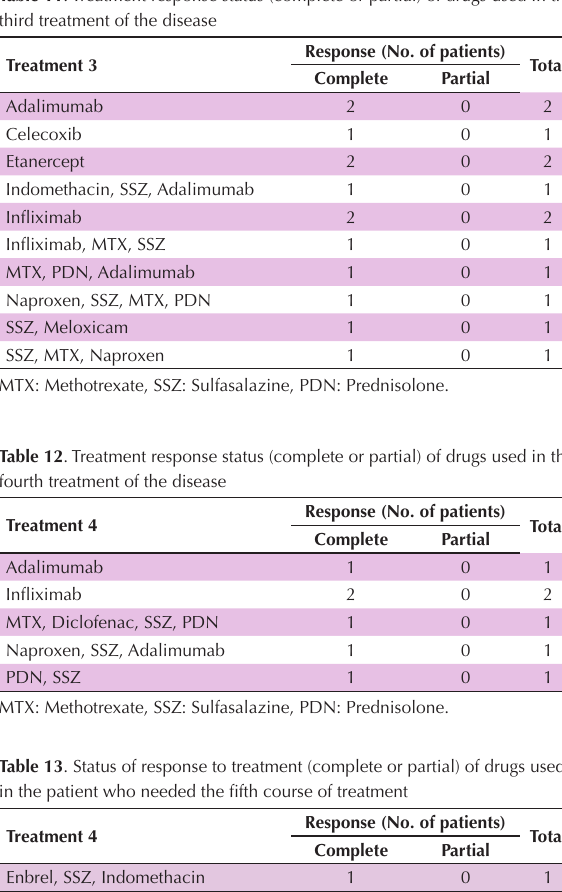
Table 11 . Treatment response status (complete or partial) of drugs used in the third treatment of the disease Treatment 3